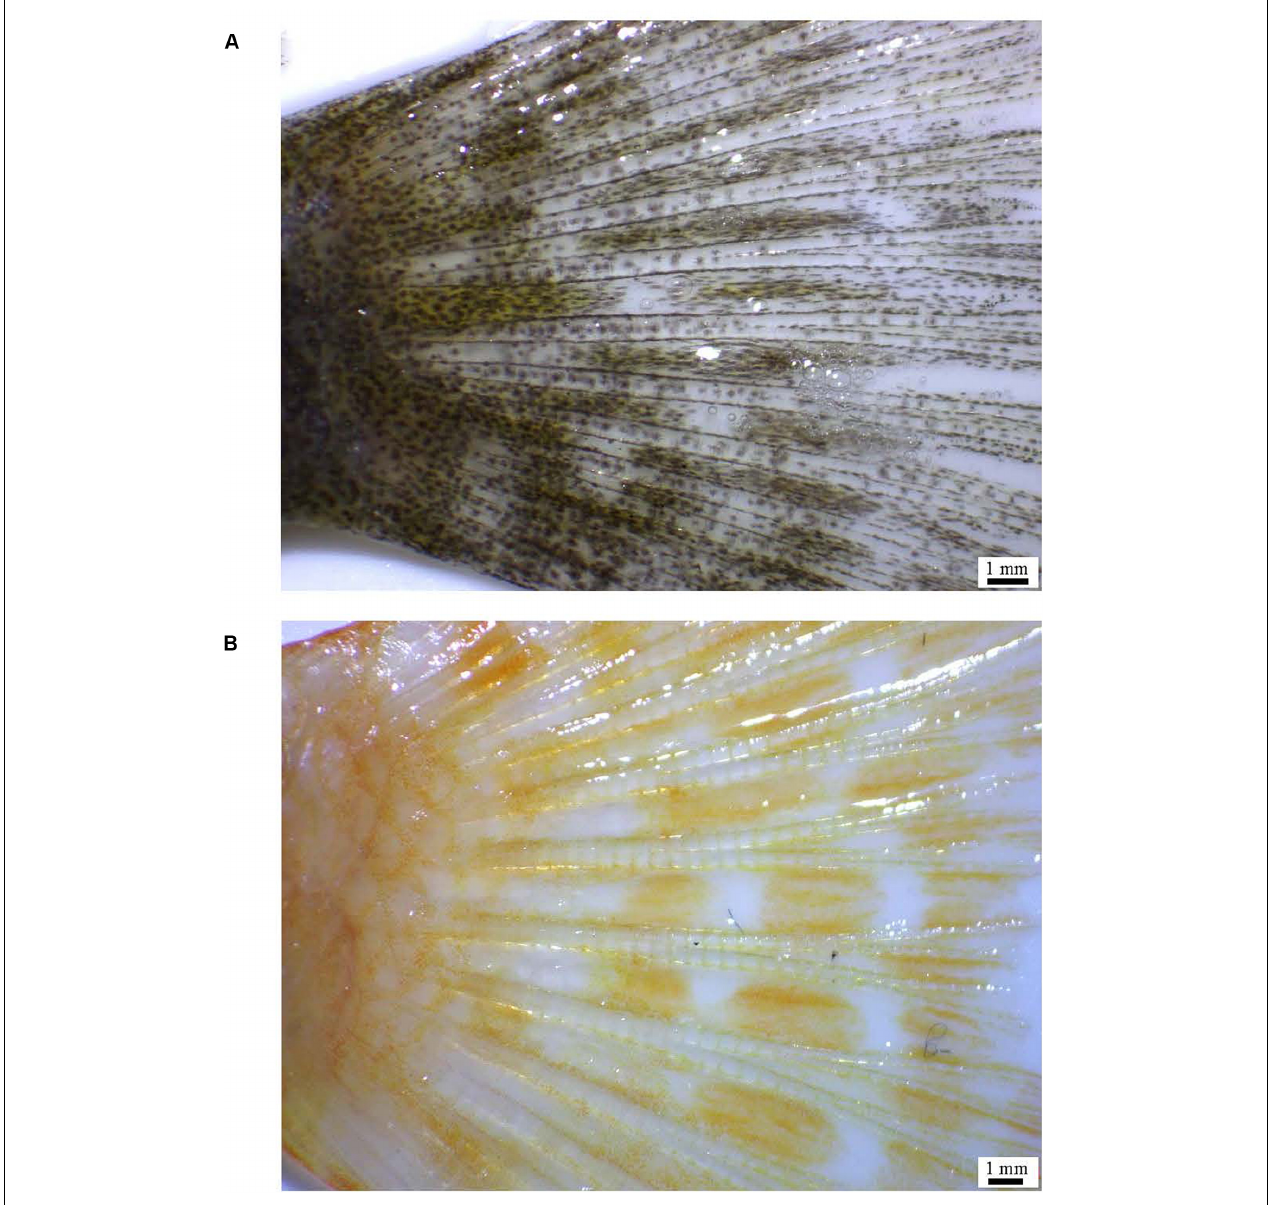
FIGURE 1 | The caudal fin of wild (A) and albino (B) , A. baenschi